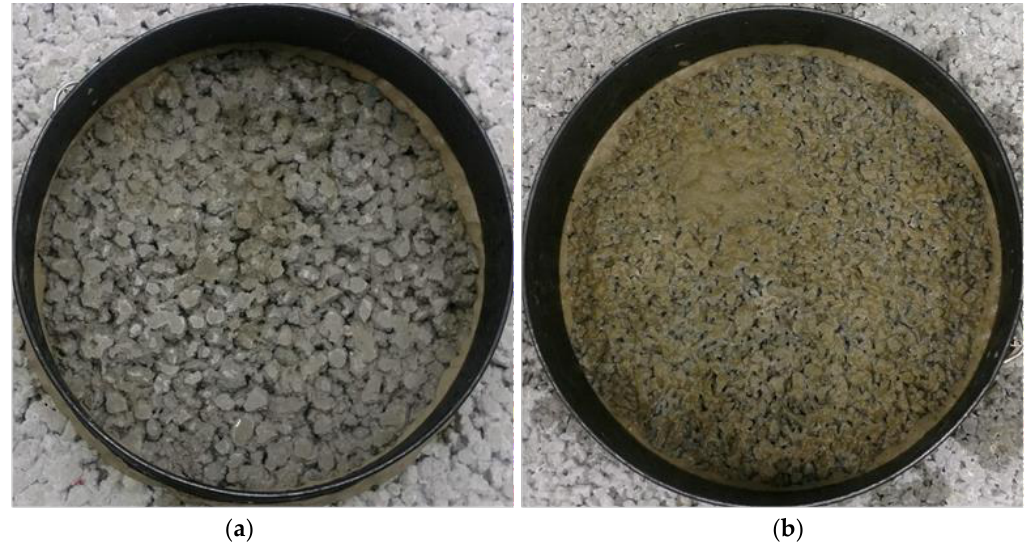
Figure 7. Sample surface after clogging test, ( a ) coarse- and ( b ) small-size aggregate mixtures.